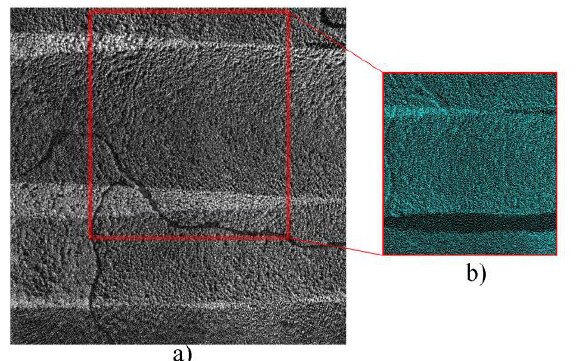
Figure 2. Flight stripe side-lap effect detected in ( a ) Return Waveform Energy (sum of waveform intensities) metric and ( b ) LiDAR point cloud with variable density In order to estimate structure and canopy fuel load variables, field data were available from 78 circular plots with 16 m radius (see plot distribution in Figure 1c). Plot positions were located with accuracy lower than 0.3 m in horizontal and vertical locations using Trimble R-8 GNSS and Leica TPS 800 total stations. All trees within plots having a diameter at breast height (DBH) greater or equal than 2.5 cm were